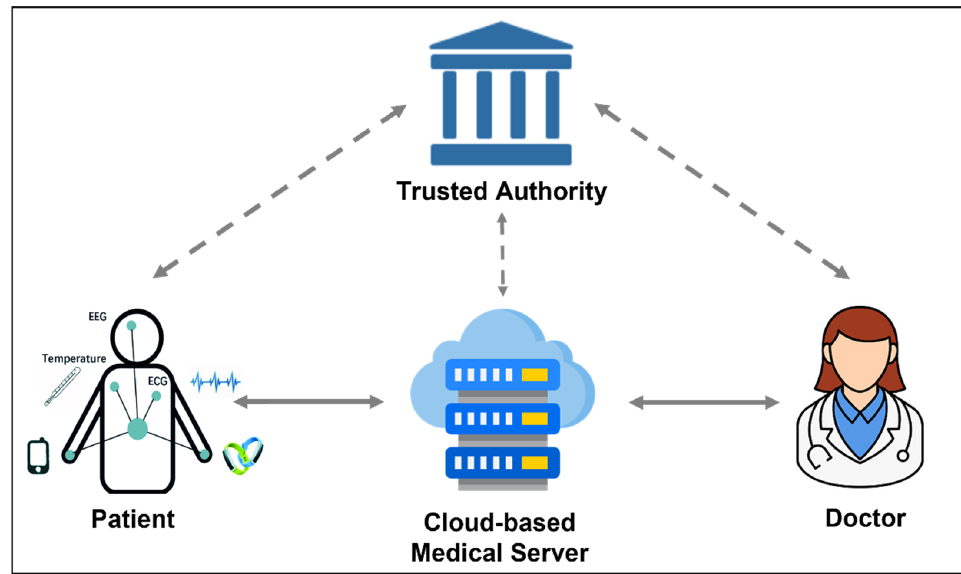
Figure 2. WBAN in a cloud-assisted environment.